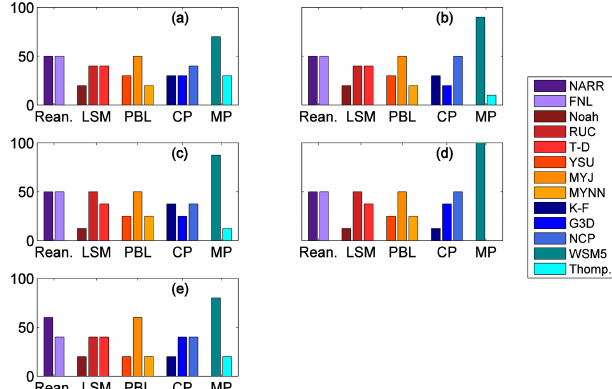
Figure 11. Frequency with which the physics schemes are used for the SA (a, c, e) and GA (b, d, e) calibrated ensembles of 10 mem- bers (a, b) , 8 members (c, d) and 5 members (e)